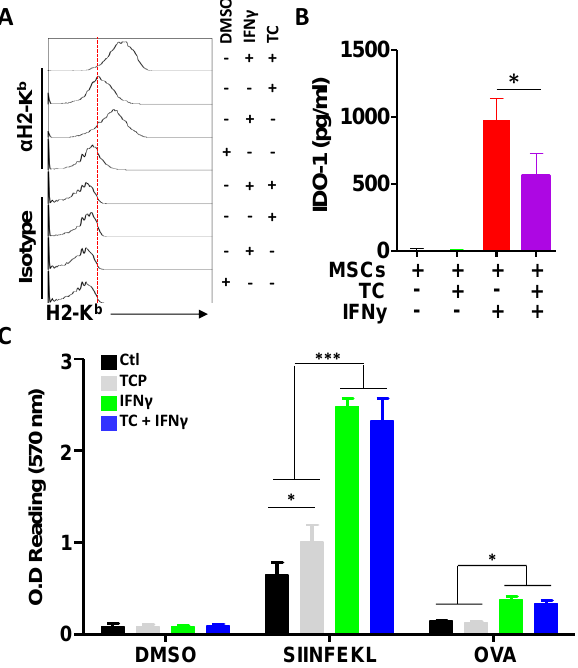
Figure 5. IFNγ and TC co-treatment does not trigger additive or synergistic effects. ( A ) Representative flow-cytometry experiment assessing the expression levels of H2-K b in response to DMSO, IFNγ, or TC, alone or in combination with IFNγ. ( B ) IDO-1 quantification following IFNγ, TC, or combined treatments. ( C ) Antigen-presentation assay in response to IFNγ, TC, or combined compounds following SIINFEKL or OVA pulsing. For all panels shown in this figure, n = 6/group with * p < 0.05 and *** p < 0.001.